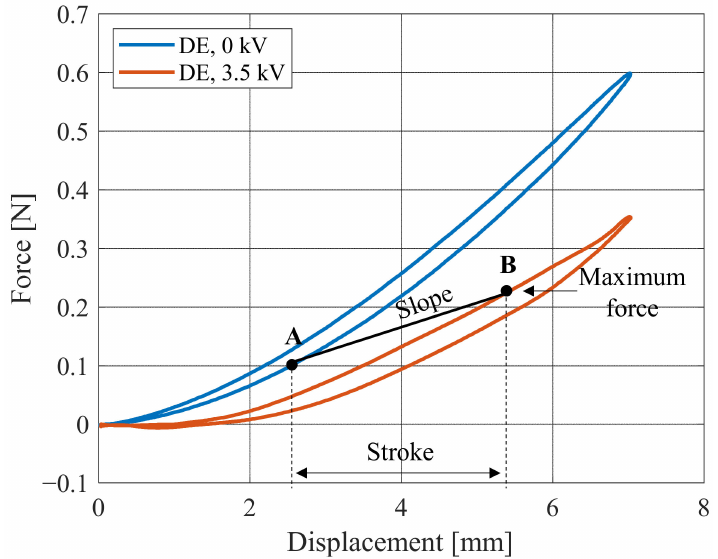
Figure 14. Intersection between the DE mechanical characteristics without (solid blue line) and with (solid red line) applied voltage, and ideal biasing behavior ensuring large stroke (solid black line). Points A e B represent the system equilibrium points for low and high voltage, respectively. Their distance along the horizontal axis defines the corresponding